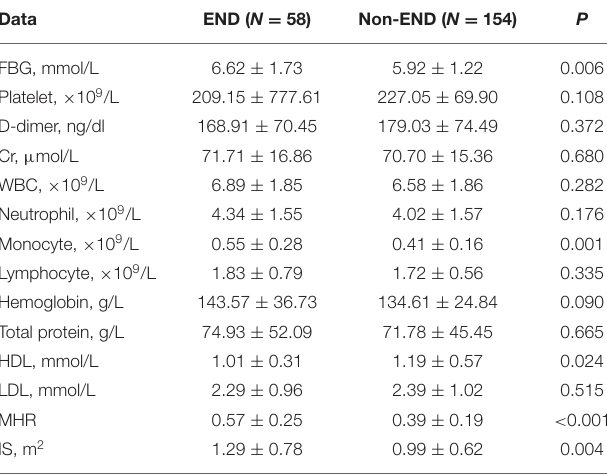
TABLE 3 | Laboratory and imaging data in the END and non-END groups. TABLE 4 | Evaluation of the effect of MHR on END following pontine infarction